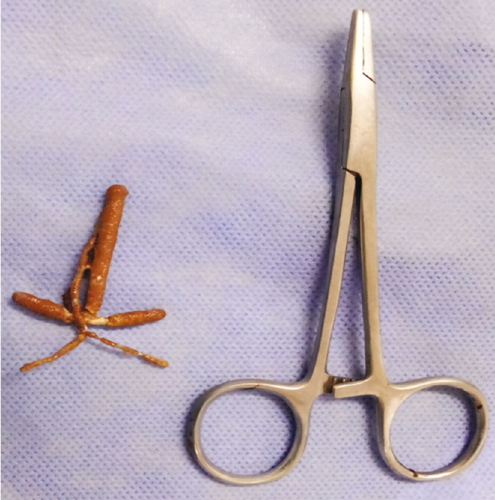
Figure 4: T-shaped intrauterine device completely